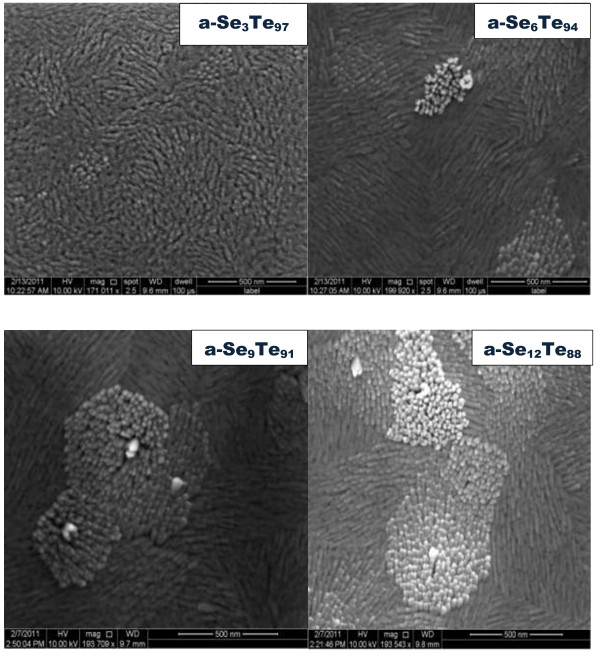
FESEM images of thin films composed of a-Se

x

Te100-x aligned nanorods.